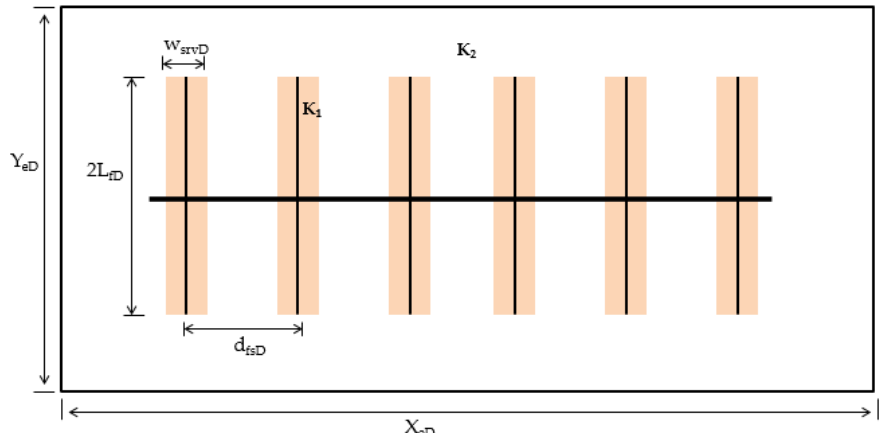
Figure 18. MHFHW model with local SRVs of six-stage fractures.